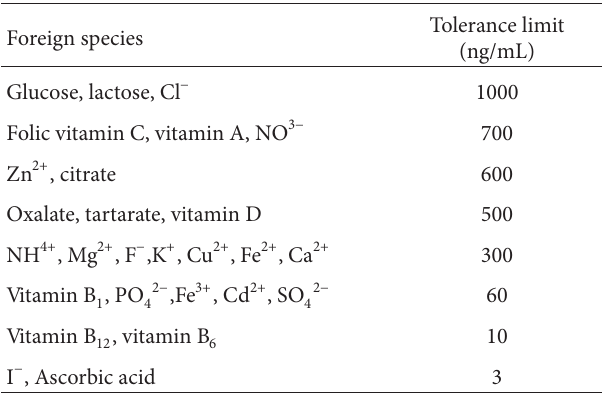
T 1: Effect of interference on extraction and determination of brilliant blue